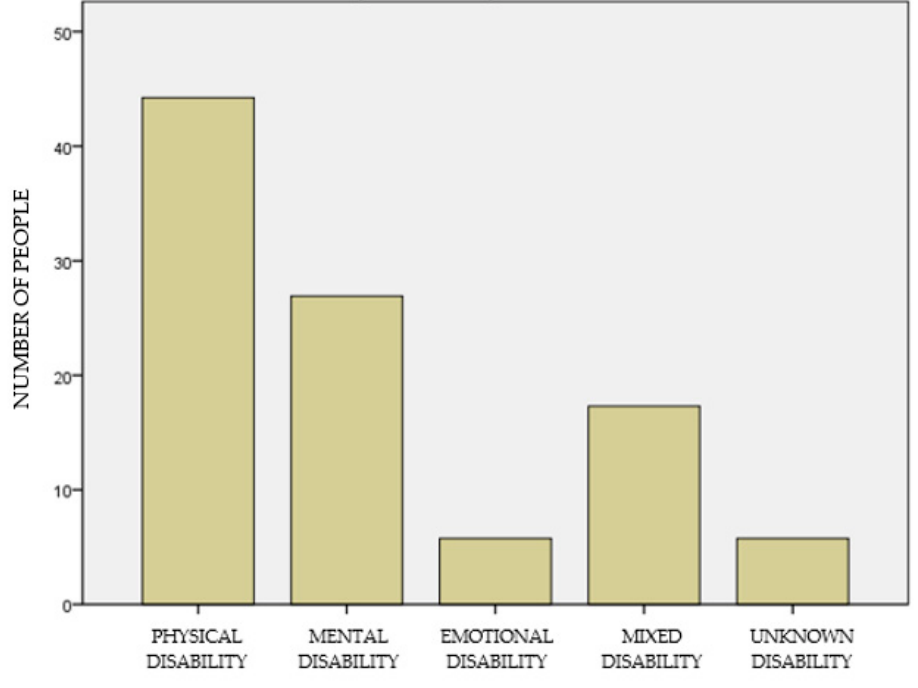
Figure 1. Type of disability.